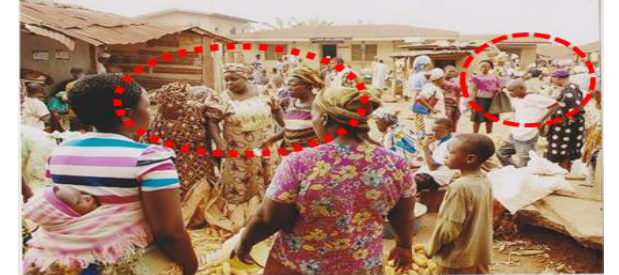
Figure 4. A sectional part of the case study market square showing diverse interactions among the users. (Source: